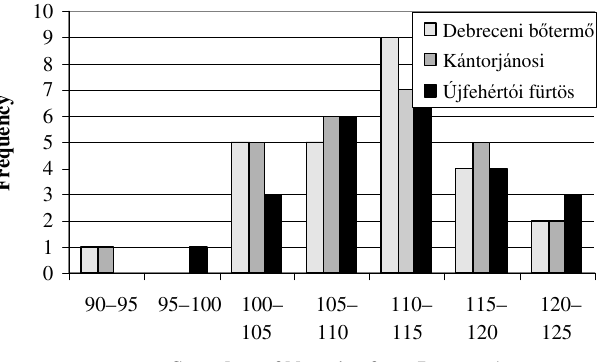
00,511,522,533,544,5